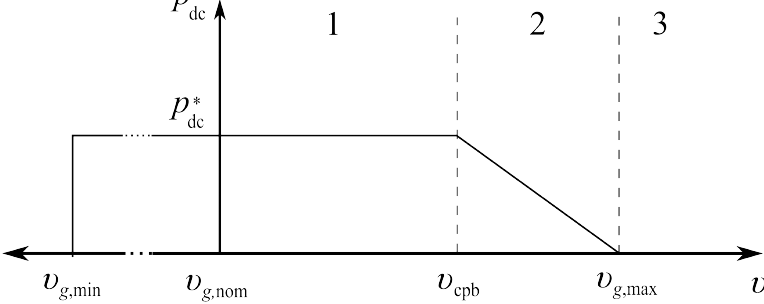
Figure 1. Active power drooping (APD) based on the voltage-based droop